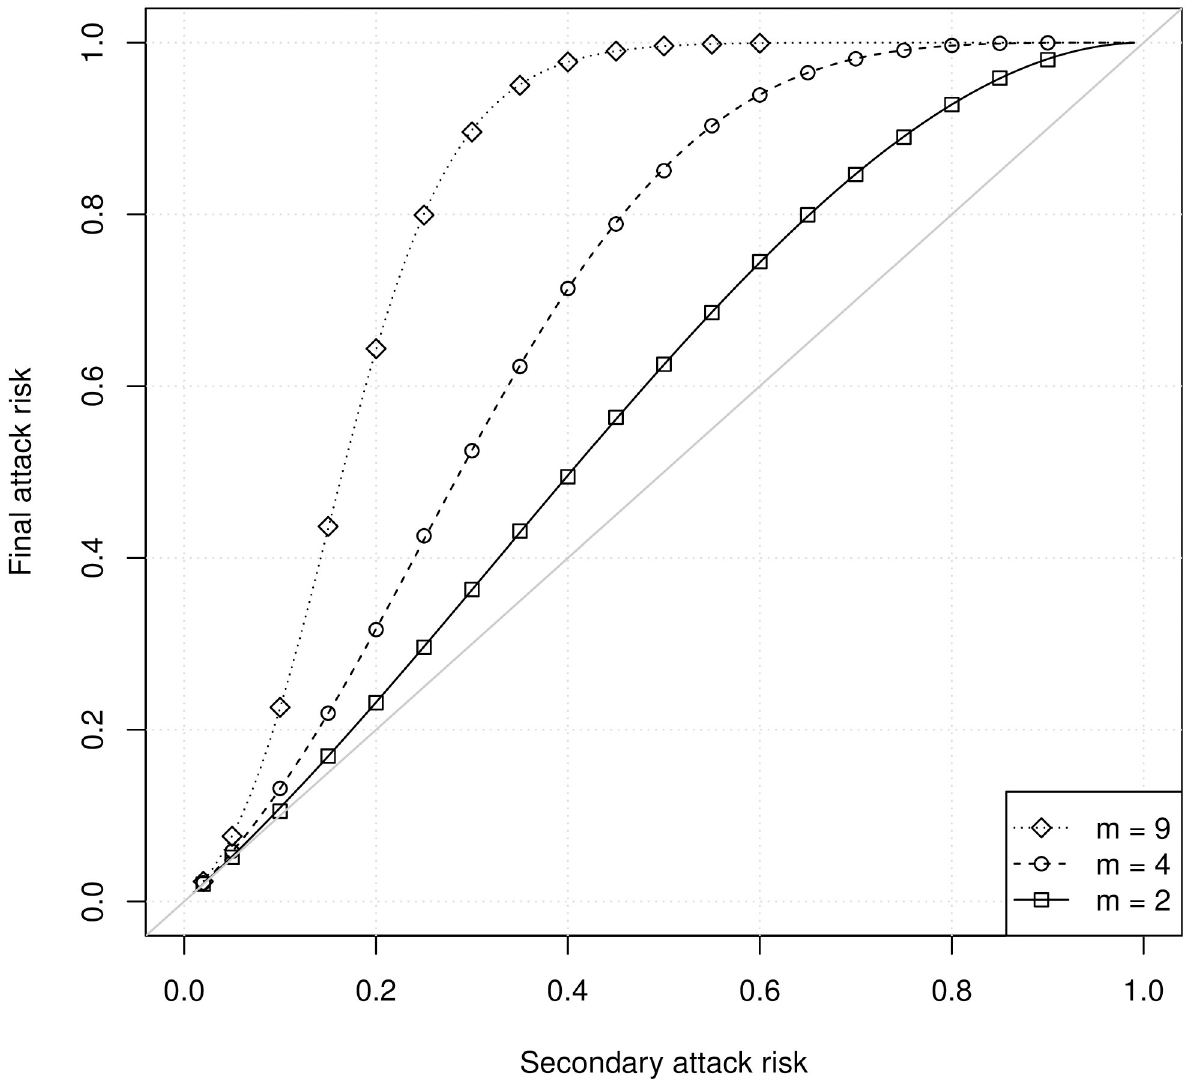
Fig 1. The household FAR as a function of the SAR for households with different numbers of susceptibles m . Lines show analytical calculations using probability generating functions, and simulations show estimates from 40,000 simulated household outbreaks. Each simulated household outbreak had a single primary case, so the total household size was m +